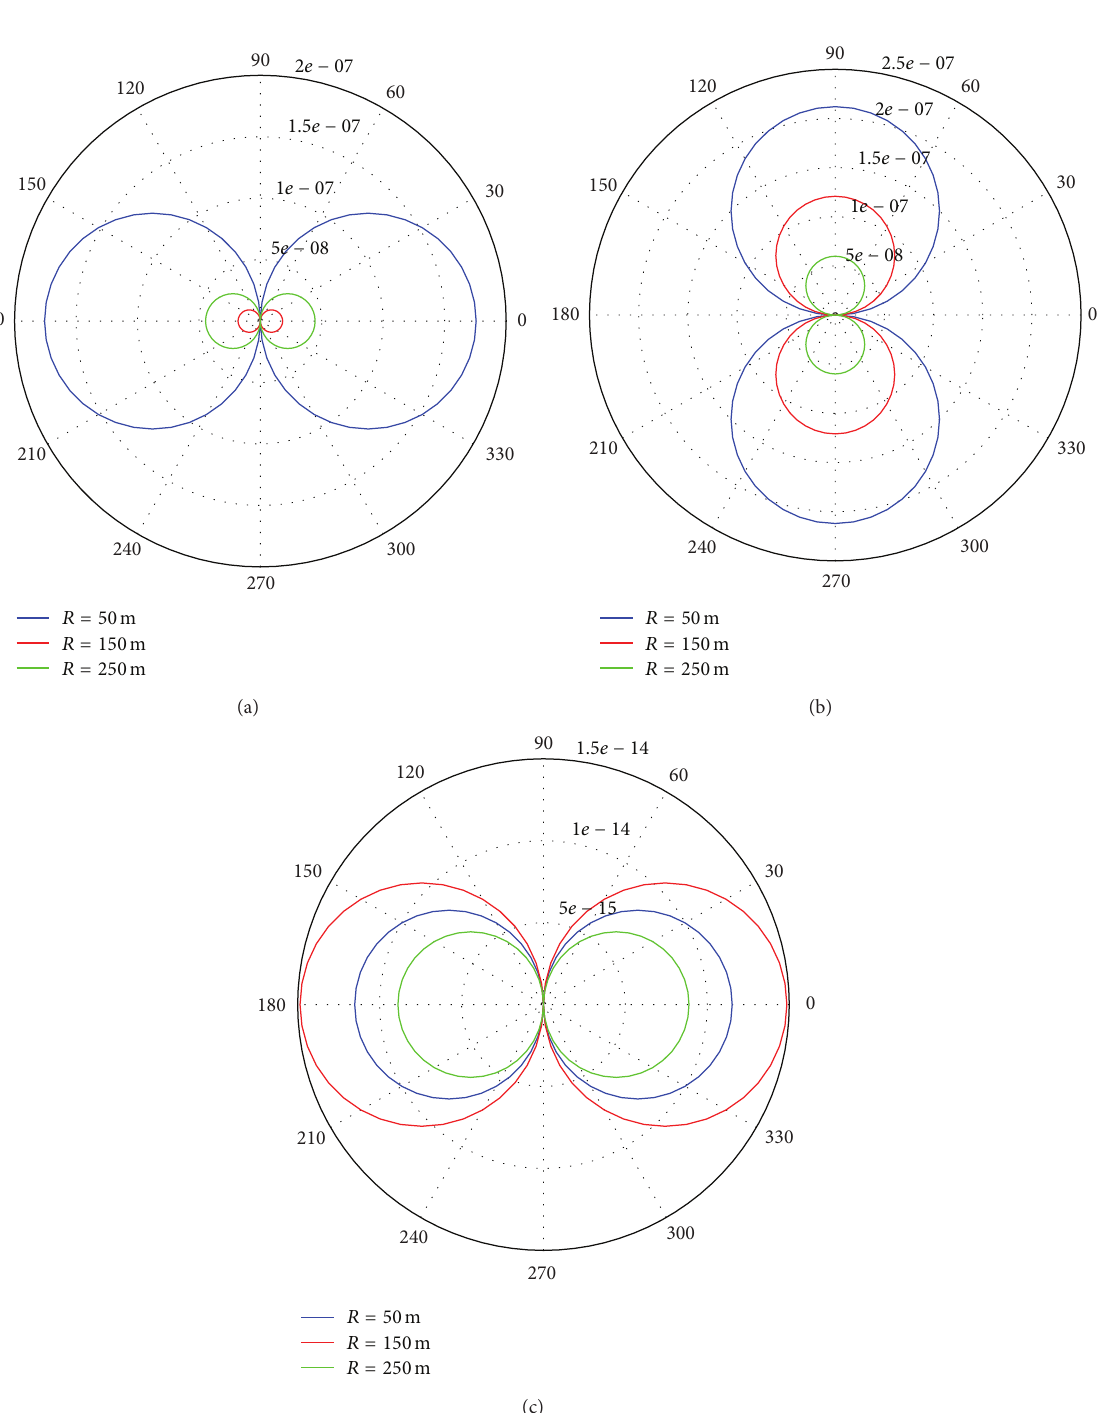
electric field. In Figure 12, it is shown that the current value tends to decrease with the increasing frequency, but the influence is too tiny to distinguish the size of the value. As shown in Figure 13, the field value at the points whose radial distances 𝑅 = 50 m and 𝑅 = 250 m decreases when the